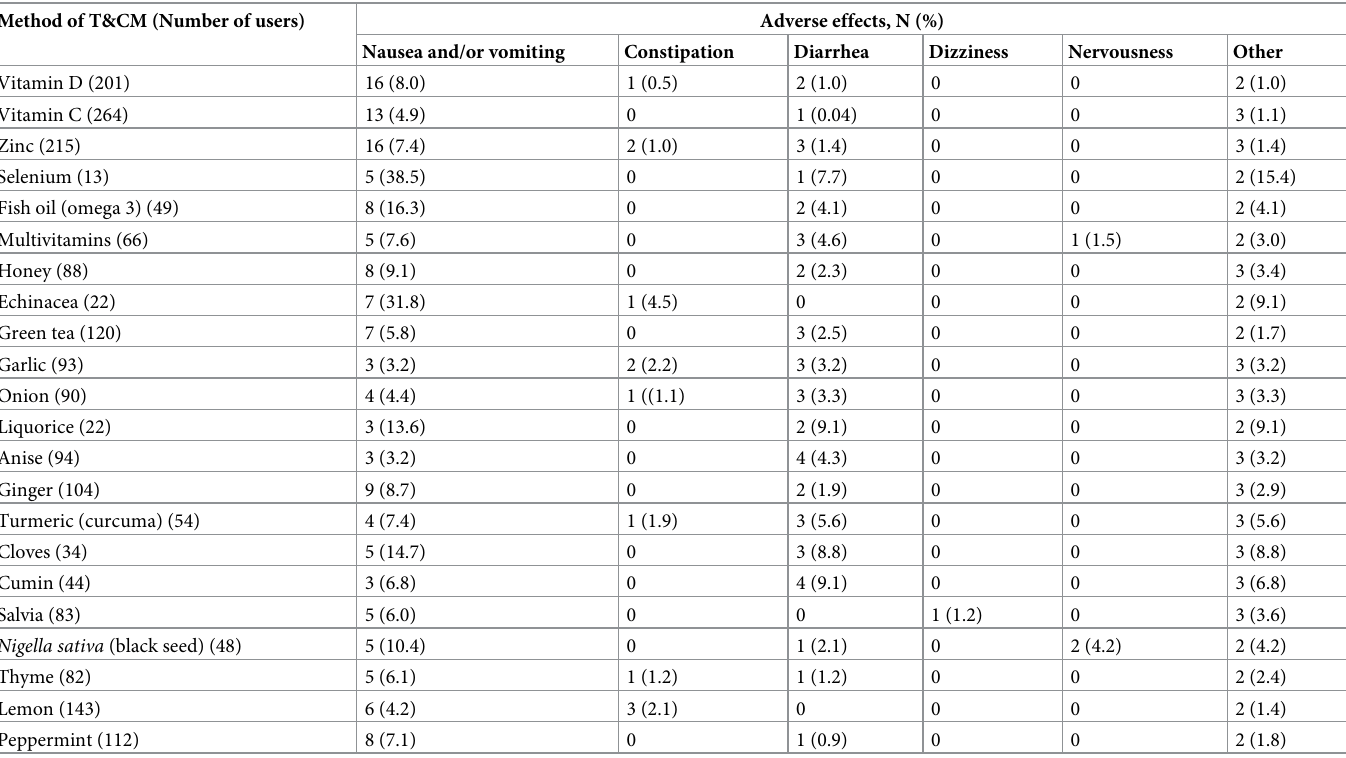
Table 5. Most common adverse effects experienced by T&CM